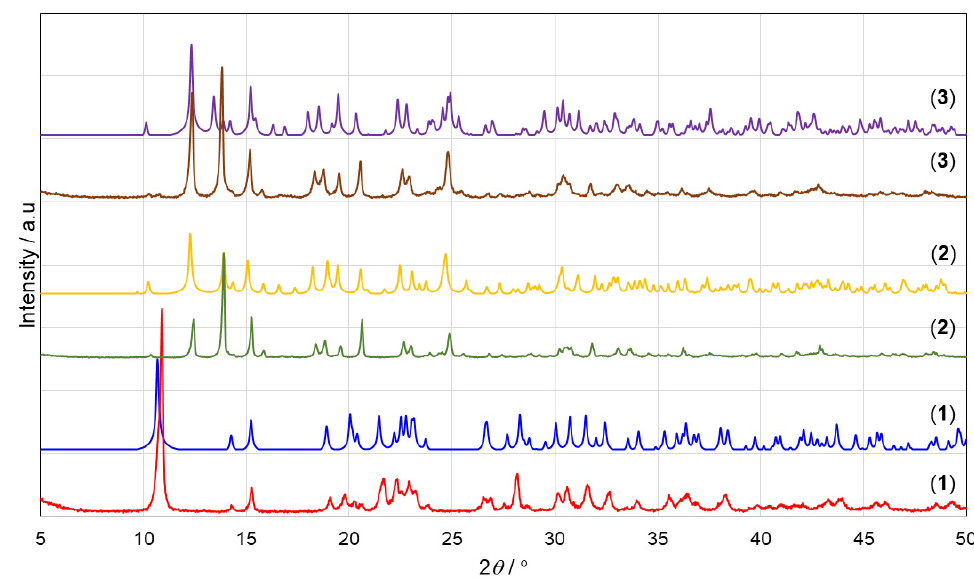
Figure 4. Overlay of experimental (red, green, brown) and calculated (blue, yellow, violet) PXRD traces for {[HgCl(pic)]} n ( 1 ), [HgCl(pic)(picH)] ( 2 ) and [HgBr(pic)(picH)] ( 3 ).